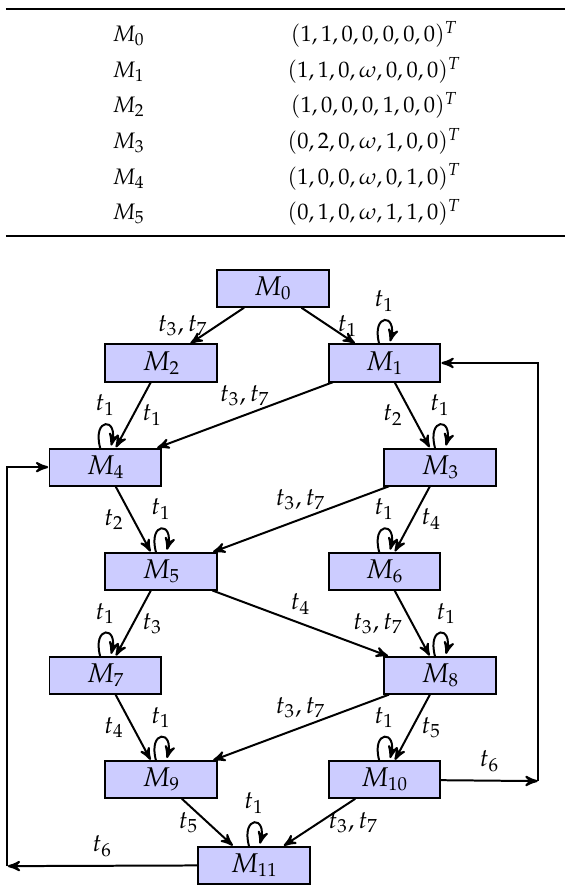
Figure 4. A coverability graph of the unbounded net